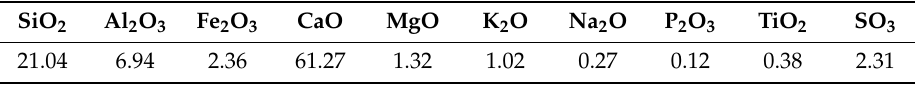
Table 1. Main Components of the Cement